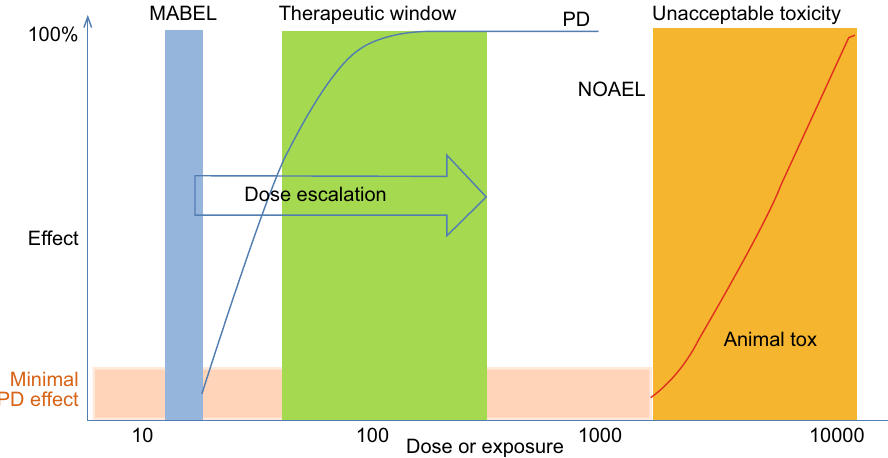
Figure7. Relationshipbe- tween MABEL, NOAEL, therapeutic window and toxicity in FIH trial. MABEL: minimally anticipated